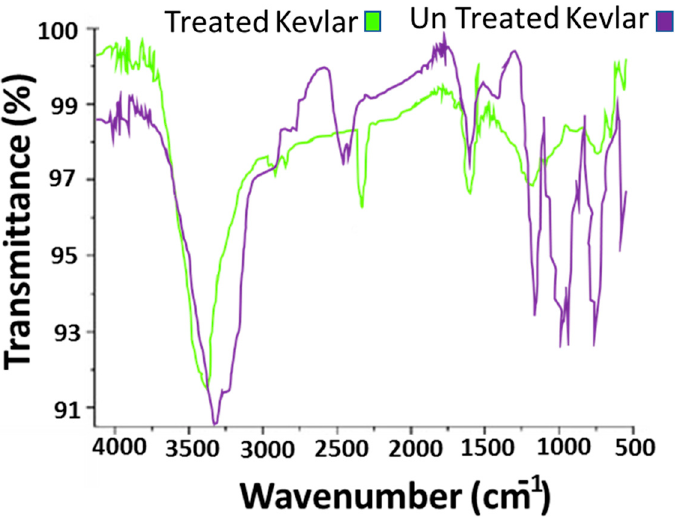
Figure 9. FTIR analysis of Kevlar surface before and after chemical treatment.